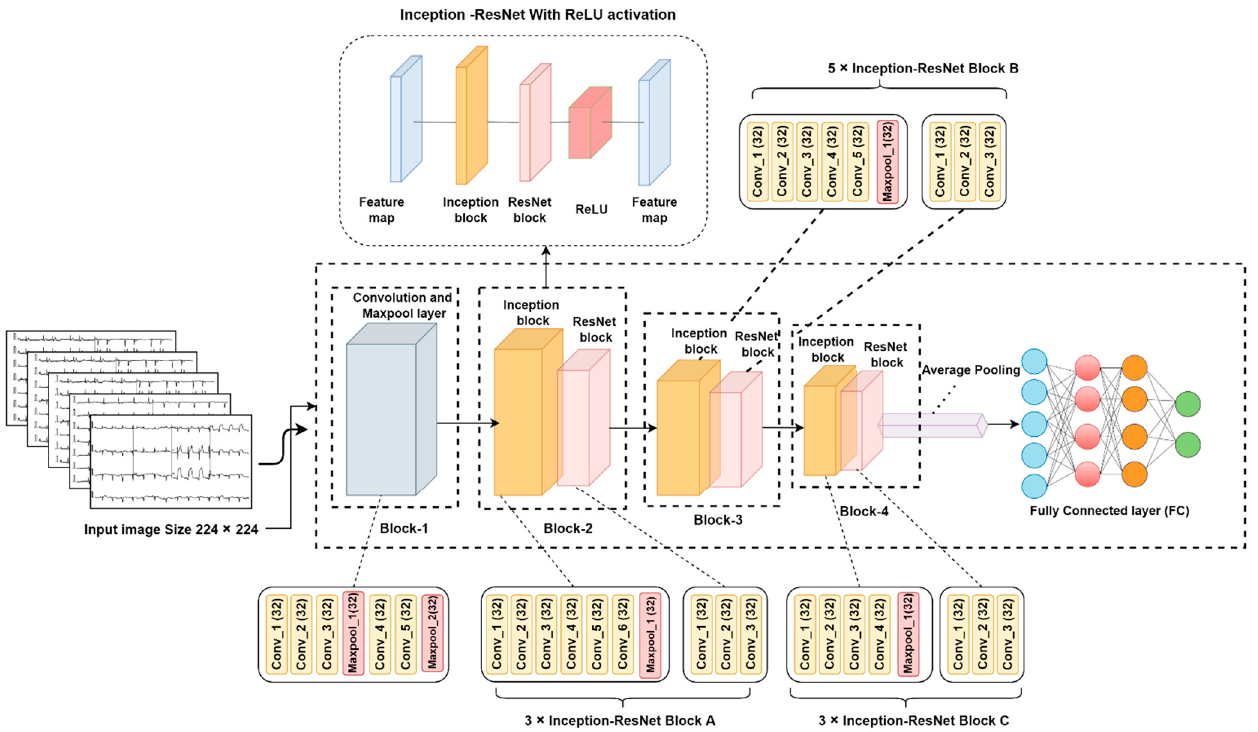
Figure 10. Base model